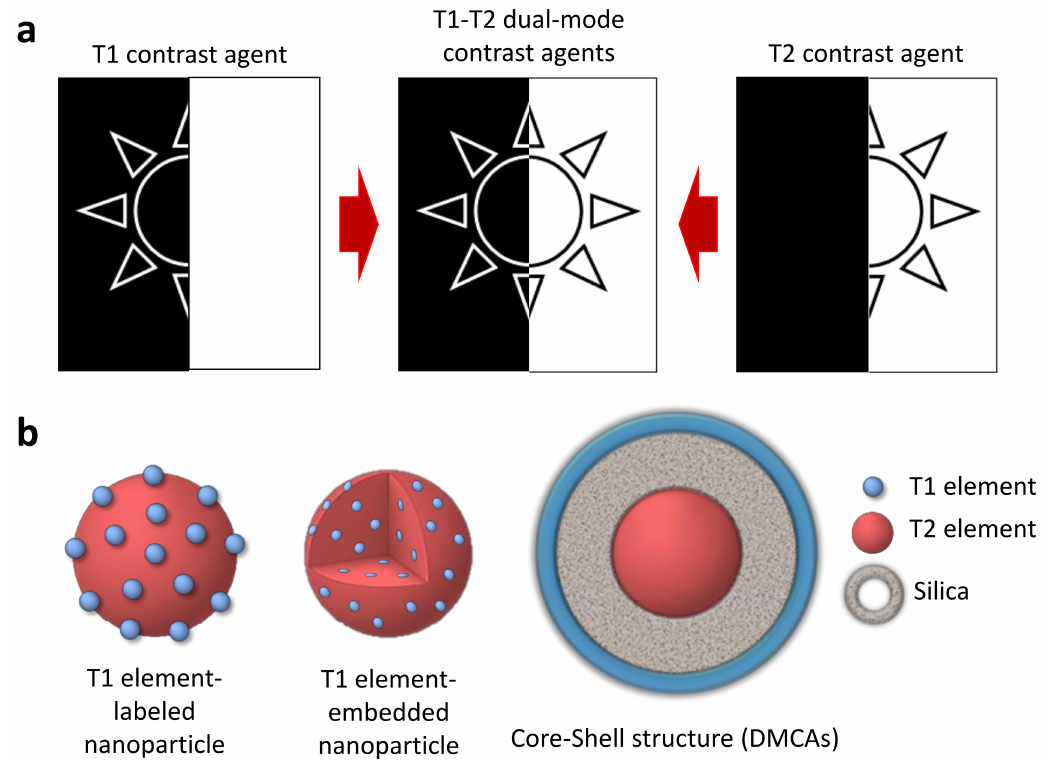
Figure 2. ( a ) Schematic representation of T1, T2, and T1–T2 dual contrast effects; ( b ) schematic illustration of three possible structures for a T1–T2 dual-mode contrast agent. Adapted with permission from [15], Copyright 2021 Elsevier